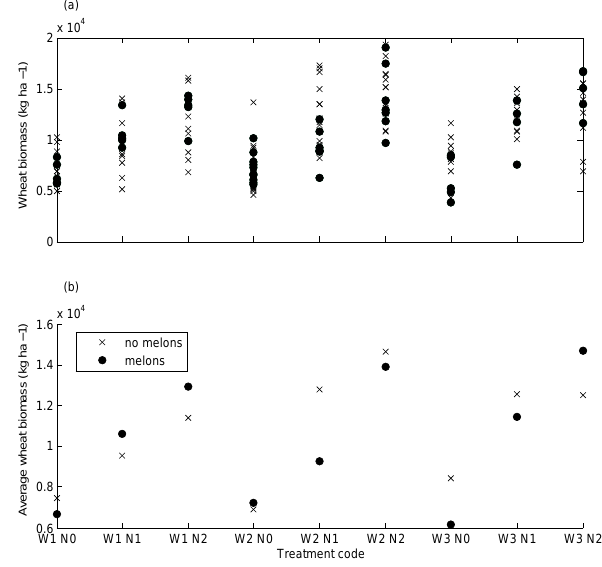
Fig. 3. (a) Wheat biomass (kg ha − 1 ) from locations where melons once grew ( • ) and where they did not ( × ) plotted against fertigation treatment type, and (b) the mean for each treatment plotted against treatment type. Treatment types were as follows. Total irrigation levels of 342.6, 552.9 and 755.9mm are denoted W1, W2, and W3 respectively. Fertilizer treatments of 0, 150 and 300kg ha − 1 are denoted N0, N1 and N2